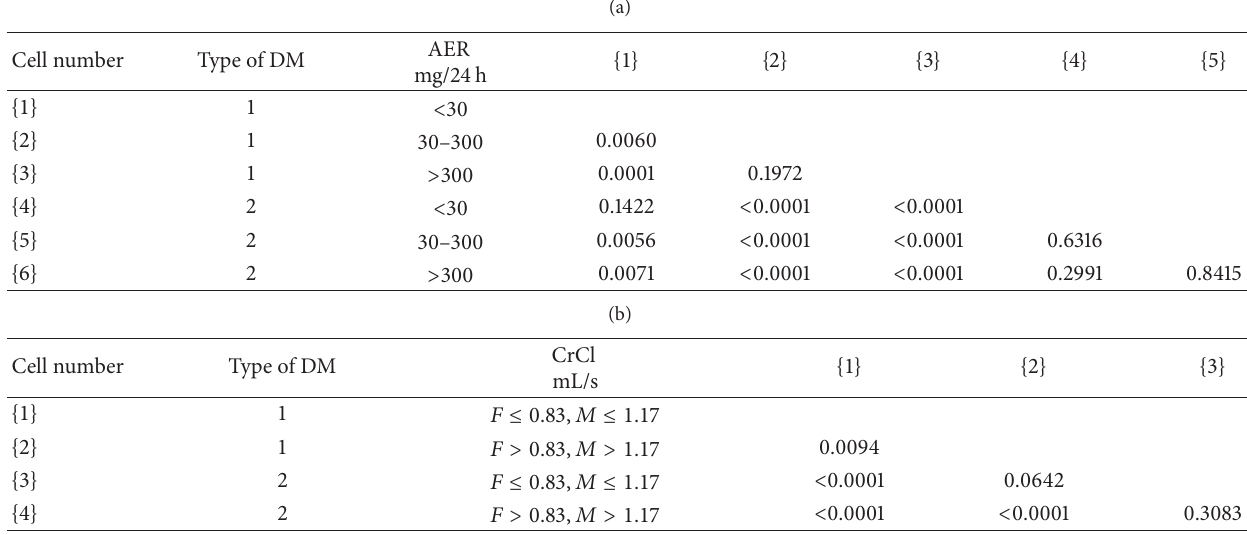
Table 3: Interaction between the type of diabetes and AER and the type of diabetes and CrCl for ApN as dependent variable using Tukey’s HSD post hoc test.